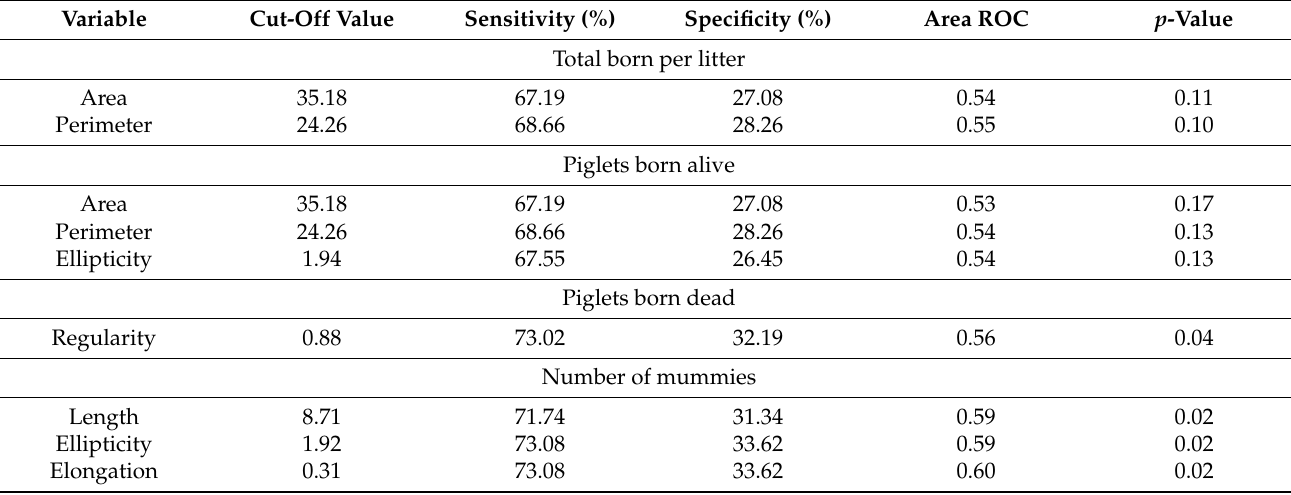
Table 5. Cut-off values of morphometric sperm variables significantly related to litter size variables calculated from receiver operating characteristic (ROC)